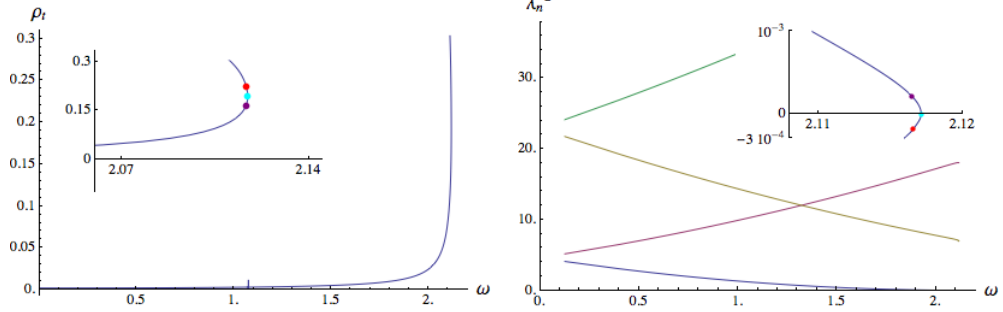
Figure 2 . Left: line of TPSs with (cid:26) = 0 : 001. In the inset, purple, cyan and red dots mark solutions below, on and above the turning point respectively. Right: Floquet exponents (cid:21) 2 for the TPSs shown in the left plot. Solutions above the turning point become linearly unstable (Im( (cid:21) 0 ) 6 = 0). In the inset, we zoom in this behavior. The color coding is the same as for the left